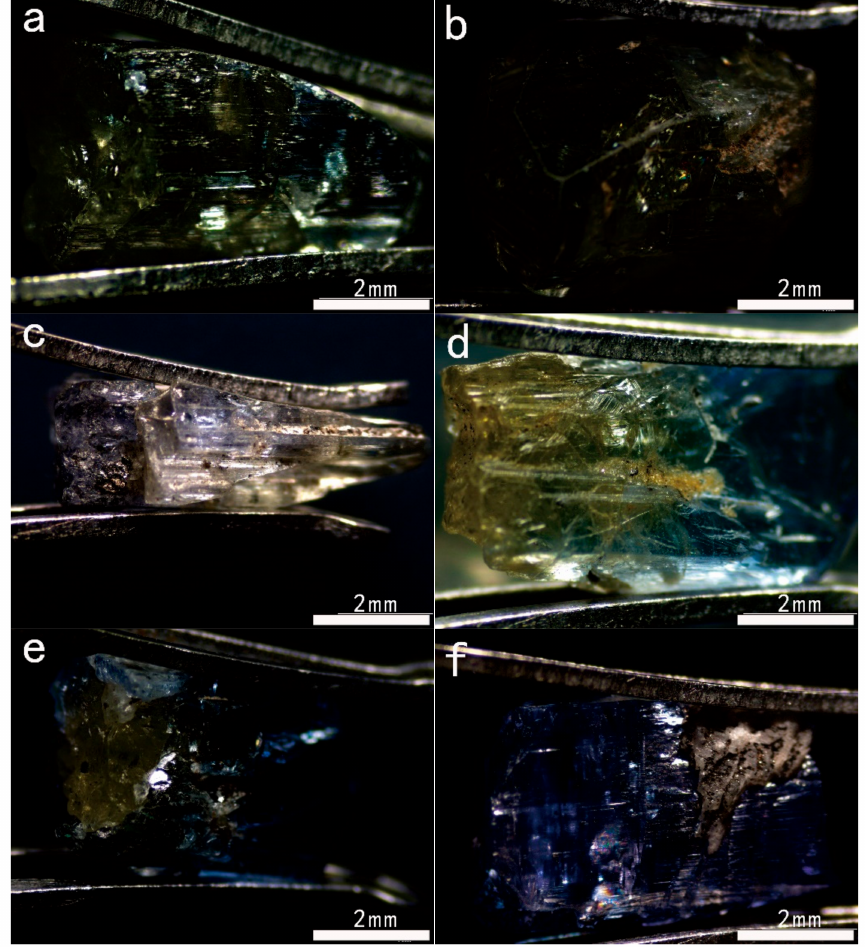
Figure 2. ( a ) Magnified image of tanzanite sample N3; ( b ) magnified image of tanzanite sample N4; ( c ) magnified image of tanzanite sample N5; ( d ) magnified image of tanzanite sample N7; ( e ) magnified image of tanzanite sample N8; ( f ) magnified image of tanzanite sample